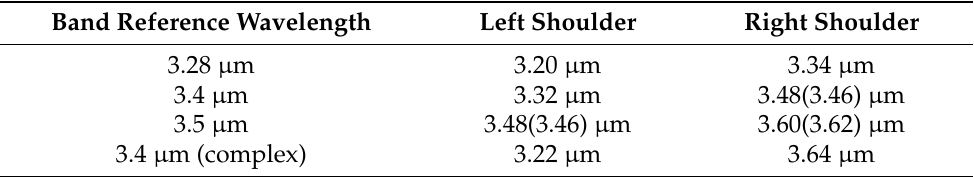
Table A2. Endpoints (left and right shoulder) for the computation of continuum-removed spectra of kerite absorption bands. Values in parentheses, when indicated, refer to the kerite 45–63 sample